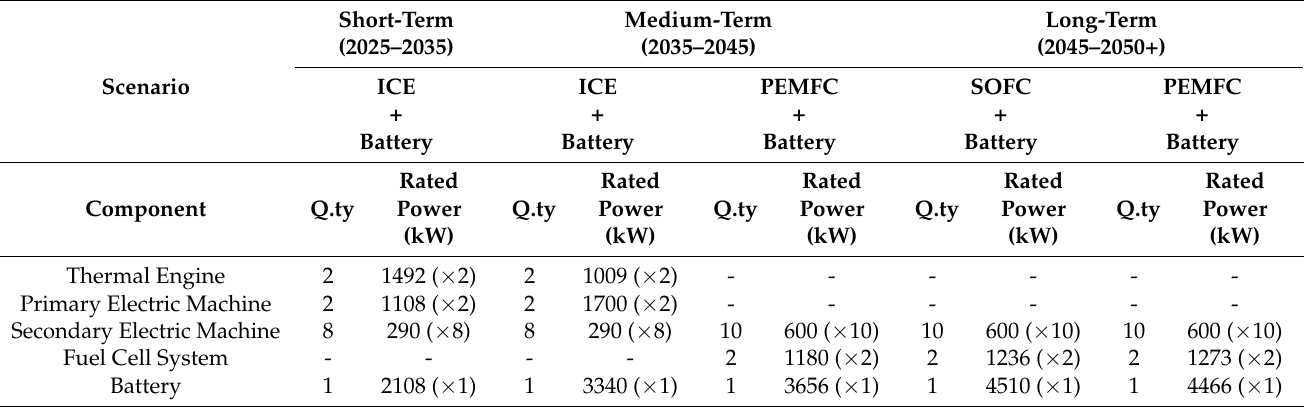
Table 9. Rated power of main powertrain